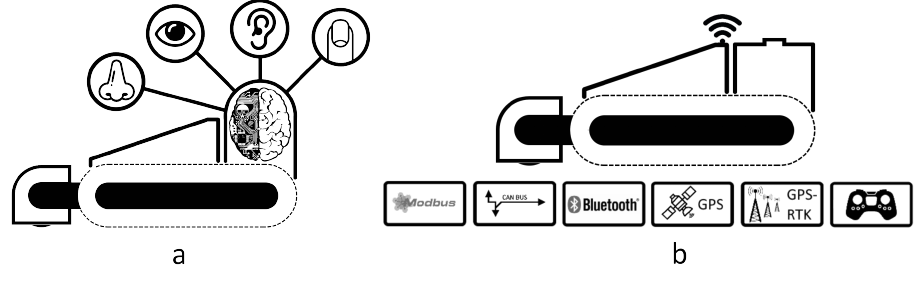
Figure 7. Key metrics: ( a ) communications; ( b )